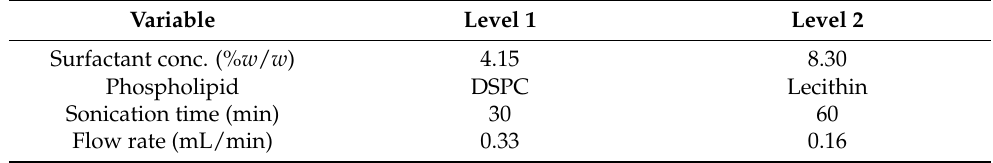
Table 4. Variables and levels of assessment.